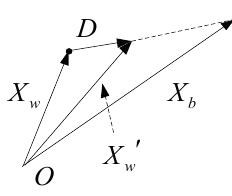
Figure 6. Schematic chart of frog leaping